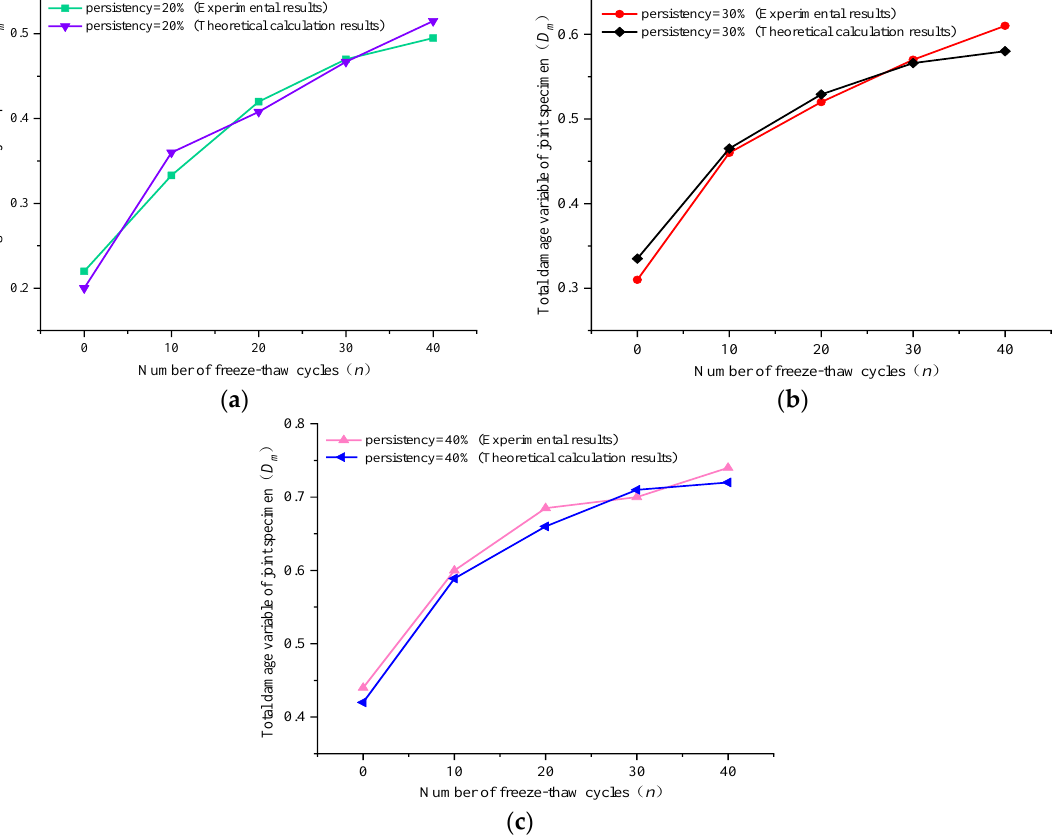
Figure 7. Comparison between the calculation and experimental results for the total damage variables in freeze–thaw shear of ( a ) persistency = 20% joint specimens, ( b ) persistency = 30% joint specimens, and ( c ) persistency = 40% joint